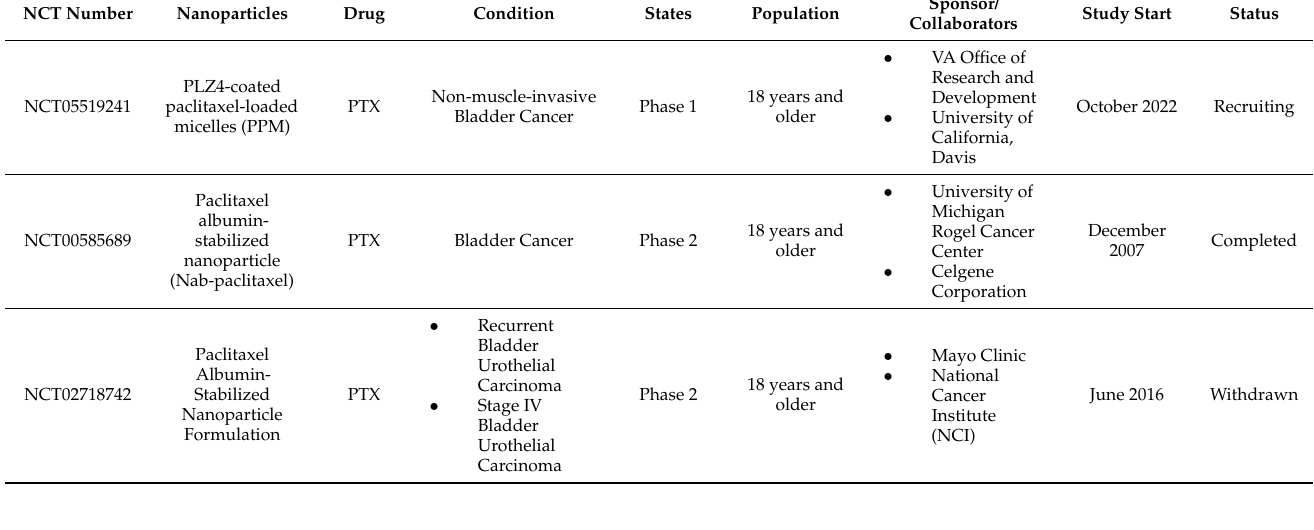
Table 1. Clinical trials of drugs with nanoformulations for BCa therapy in the United States of America (https://clinicaltrials.gov, access date: 4 January 2023).